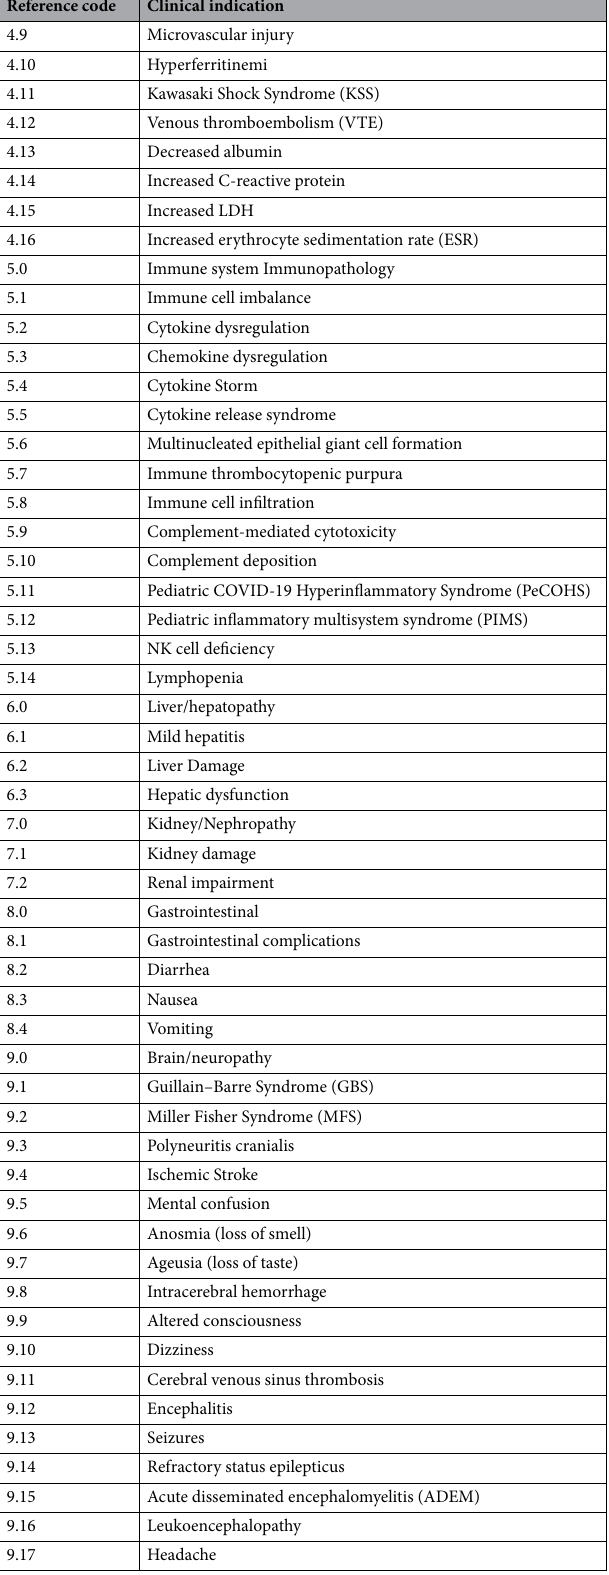
Table 1. Clinical indications and symptoms associated with SARS-CoV-2